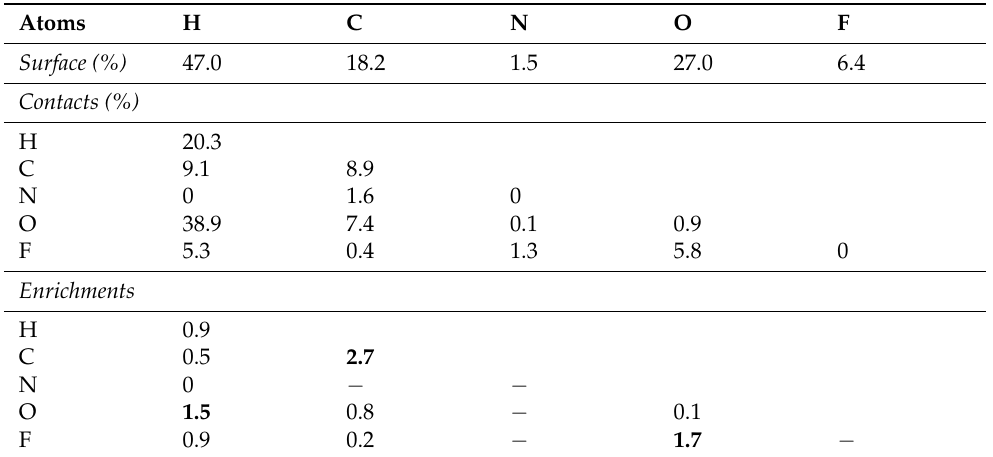
Figure 4. Two-dimensional fingerprint plots of the HS of 1 , providing a visual summary of the frequency of each combination of d e and d i across the HS. Points with a contribution to the surface are colored blue for a small contribution, and green for a great contribution. Table 3. Analysis of the intermolecular contacts on the HS of 1 , according to Jelsch et al. [18]. The first part of the table gives the surface contribution S X of each chemical type X to the Hirshfeld surface. The second part shows the proportions of the actual contacts (C XY ), and the third part indicates the enrichment ratios (E XY ) of the various contact types. Reciprocal contacts X ∙∙∙ Y and Y ∙∙∙ X are merged. The E XY were not computed when the random contacts (R XY ) were lower than 0.9%. E XY larger than unity indicate enriched contacts (in bold), while those lower than unity are impoverished. The percentages of actual contacts were calculated using CrystalExplorer21.5.